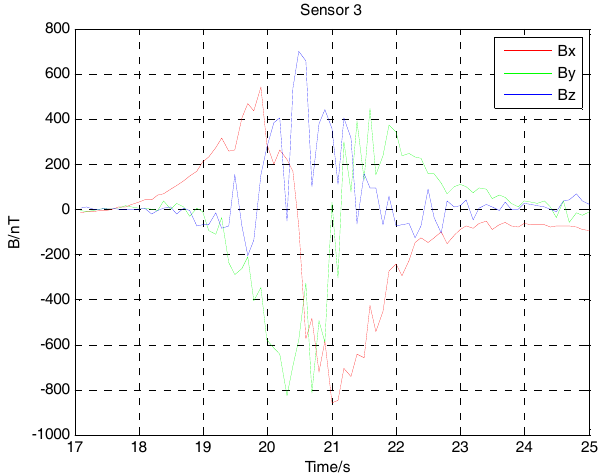
Figure 18. Magnetic field data acquired by three-component fluxgate sensor 3.